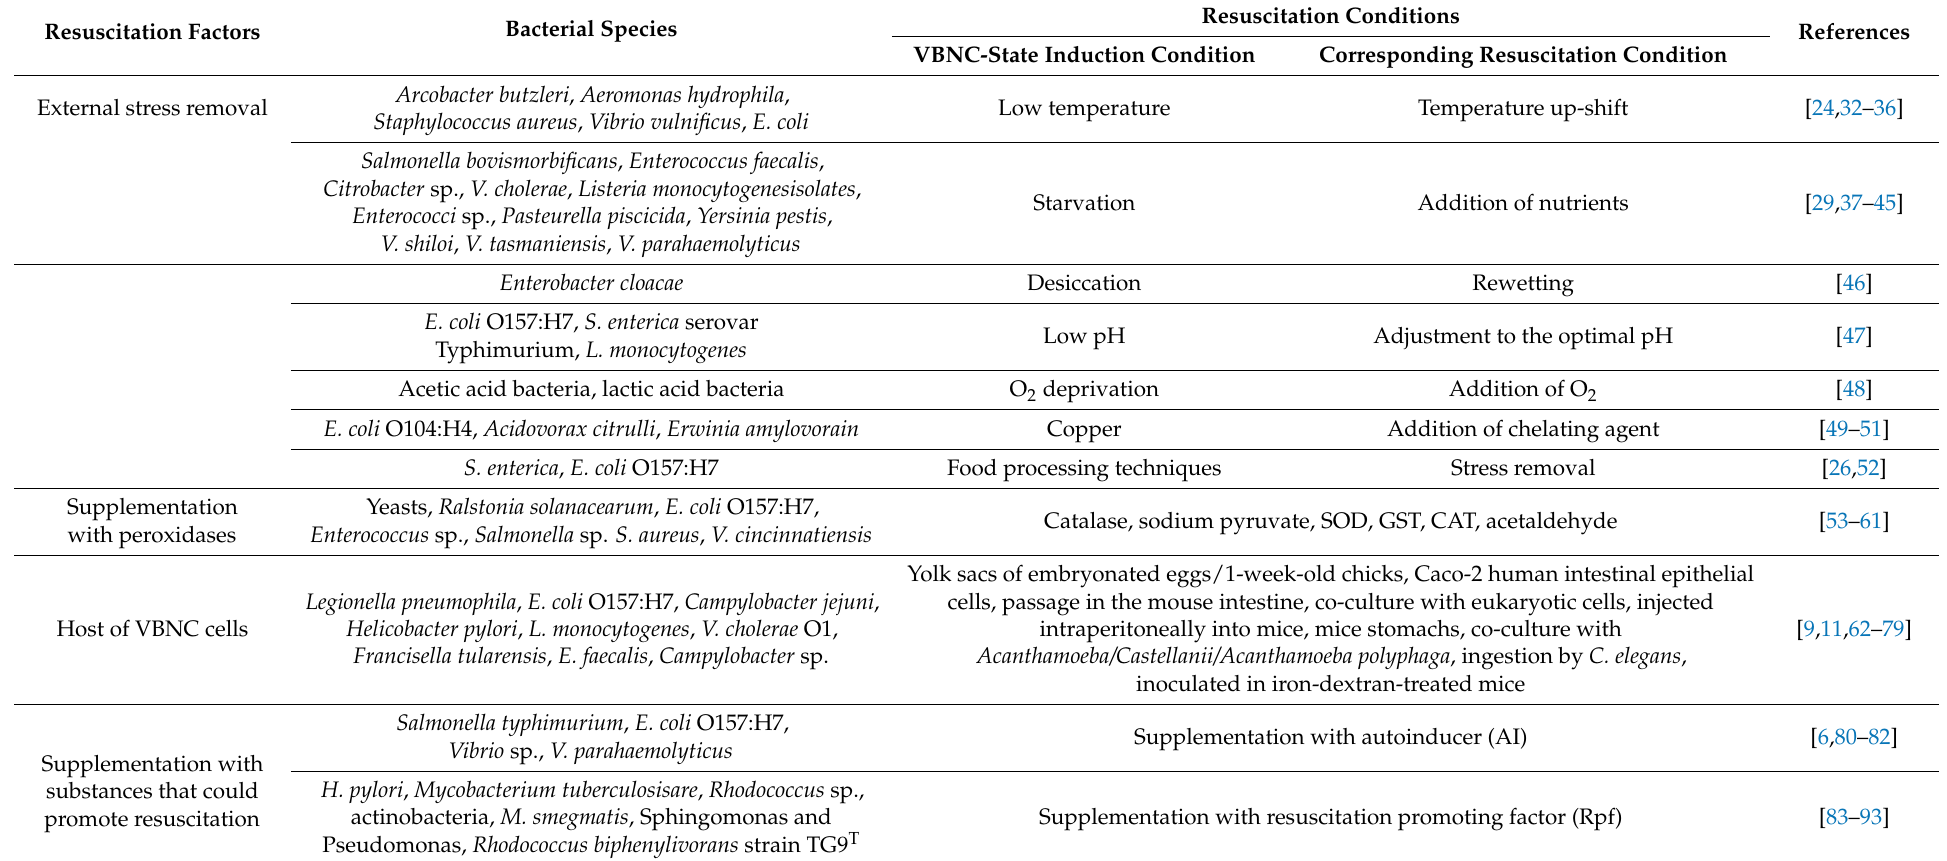
Table 1. Conditions that facilitate the resuscitation process of VBNC